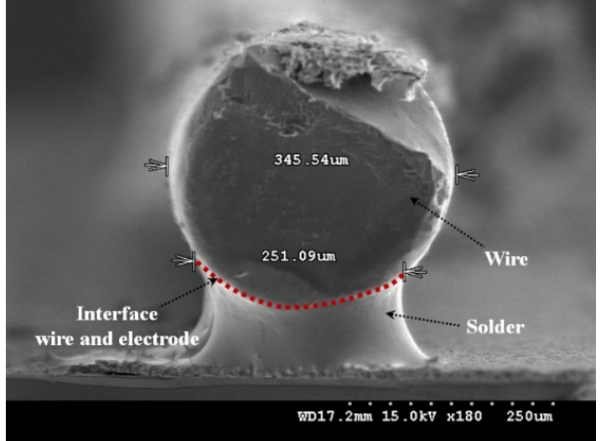
Figure 4. Cross-section of the SEM image between wire and finger electrode.